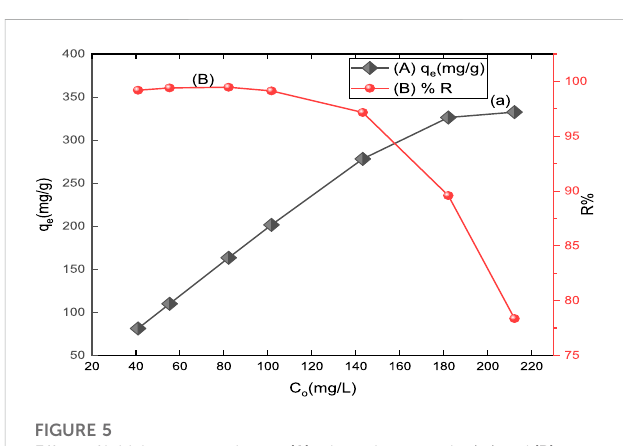
FIGURE 5 Effect of initial concentration on (A) adsorption capacity (q t )and (B) % removal (R%) of acid red 37 dye on CM- β CD:nChi:Glu (25 mg of the adsorbent for 5.0 min and pH